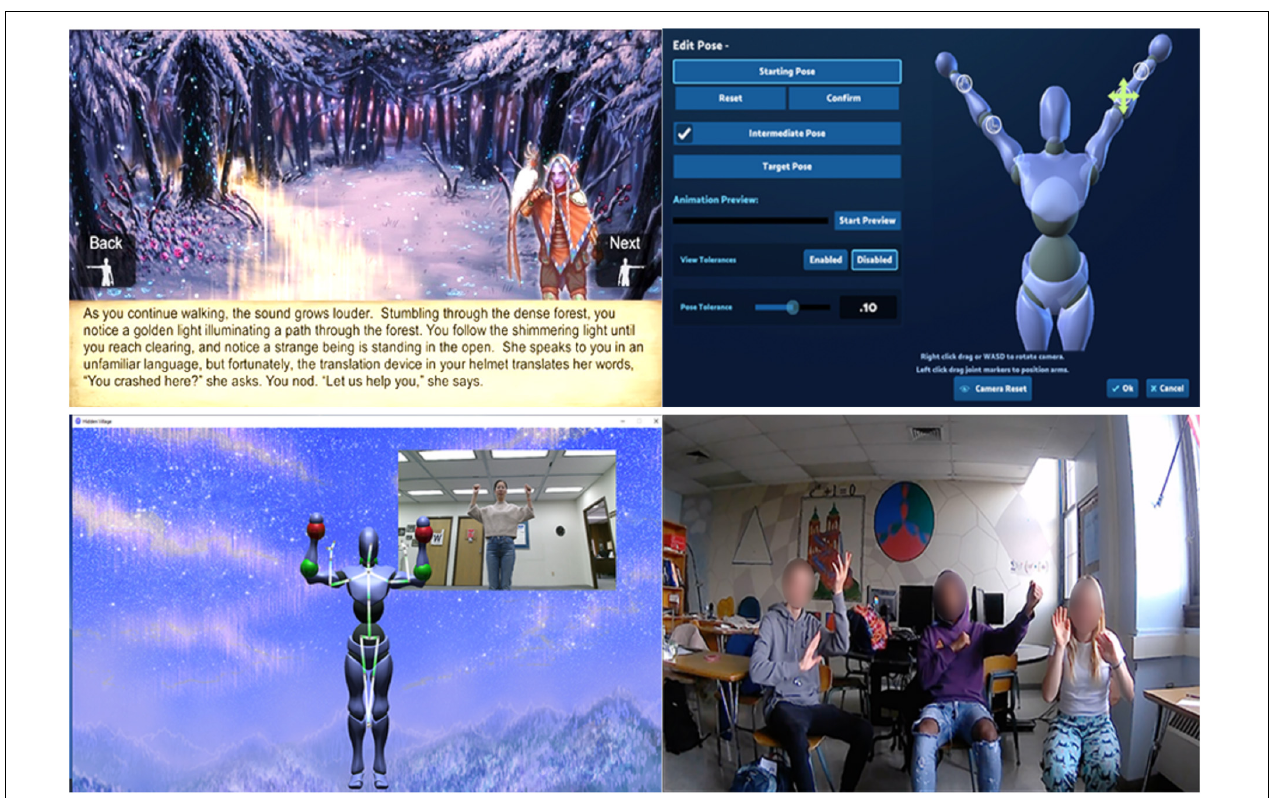
FIGURE 4 | The Hidden Village is a video game that elicits and tracks players’ mathematically relevant actions in support of their subsequent mathematical reasoning. (Top-left) Players engage with the game narrative, and (Top-right) can create their own math content with poses (Bottom-left) that are tracked in real time (with an optional skeleton overlay, as shown). (Bottom-right) Students engage in collaborative gestures during game play and while reasoning